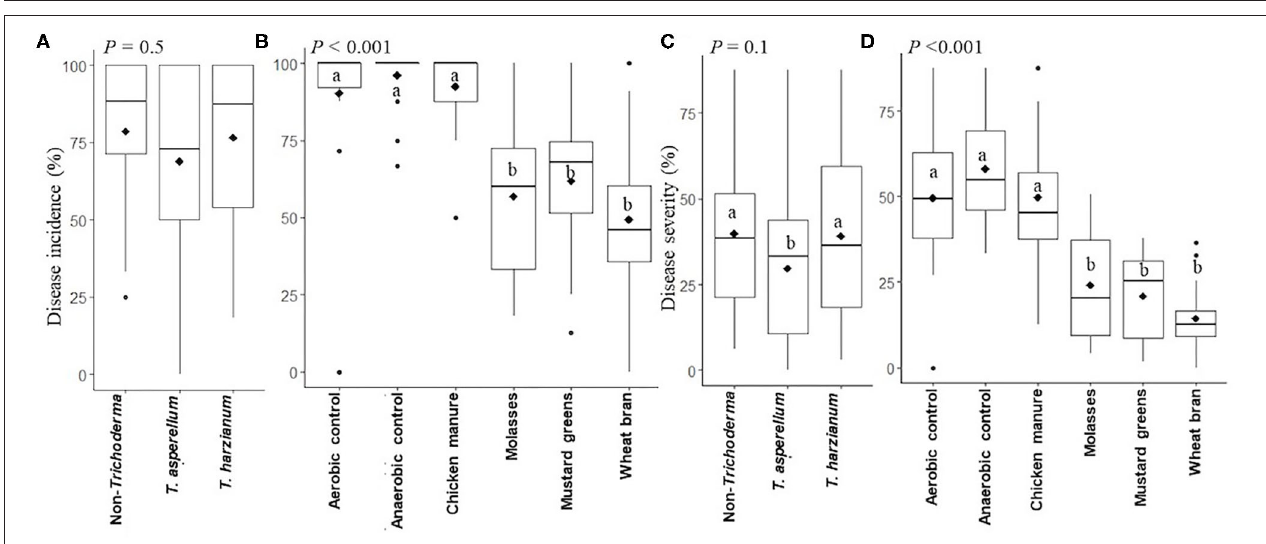
FIGURE 1 | Iron oxide paint loss from IRIS (Indicator of Reduction in Soil) tubes buried in soils amended with different carbon sources prior to anaerobic soil disinfestation affected by (A) Trichoderma isolate inoculation (main plots), (B) anaerobic soil disinfestation (ASD) carbon sources (subplots). The Y-axis is the percentage of iron oxide paint loss, an indicator of soil reducing conditions; in the boxes, black lines represent median, black diamonds represent mean values and black dots are outliers. P -value is the analysis of variance probability value after square-root transformation. Means followed by same letter(s) do not differ significantly at the indicated level of probability. Data presented are from two combined independent experiments each with three replications.